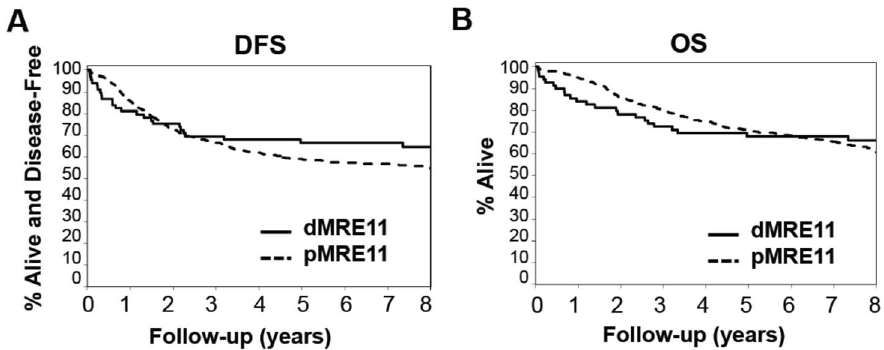
Figure 3. Tumor MRE11 status is significantly prognostic for DFS and OS. (A) Disease free survival for dMRE11 (n=70; events=24); 5-yr rate: 67% (95% CI: 56–79%) vs. pMRE11 (n=555; events=240); 5-yr rate: 59% (95% CI: 55–63%). (B) Overall survival for dMRE11 (n= =70; events=23); 5-yr rate: 68% (95% CI: 58–80%) vs. pMRE11 (n=555; events=194); 5-yr rate: 71% (95% CI: 67–75%). doi:10.1371/journal.pone.0108483.g003 PLOS ONE |